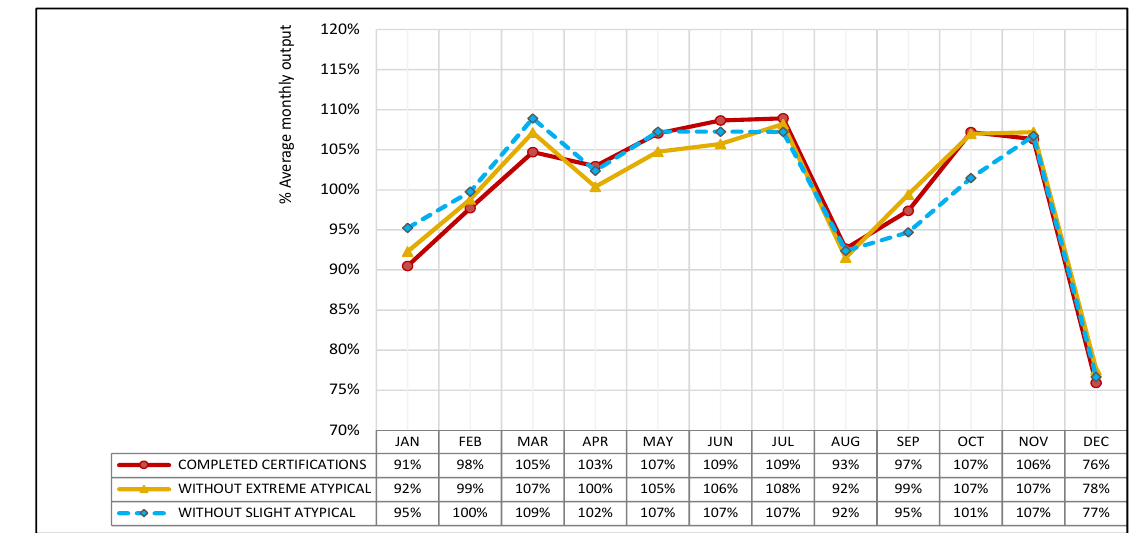
Fig. 2 Percentage of the monthly mean output involving data from completed certifications, data without extreme atypical values, and data without slight atypical values. Source: own elaboration.